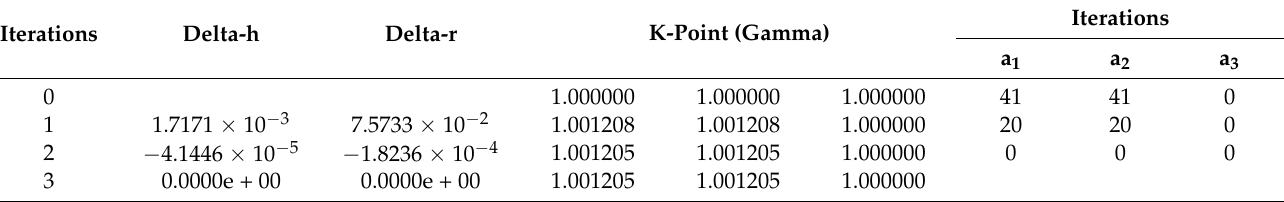
Table 2. The geometry of SWCBNNT (5,